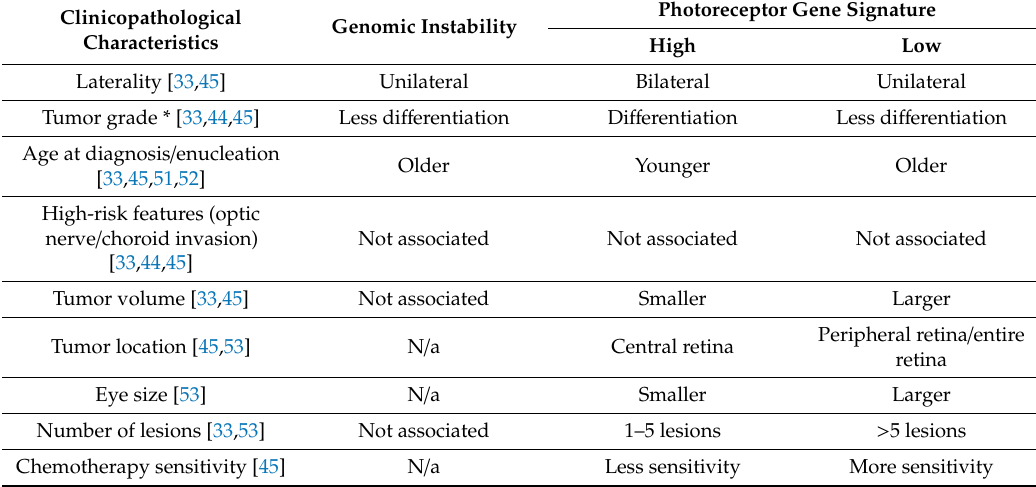
Table 2. Associations between genomic and transcriptomic features and clinicopathological